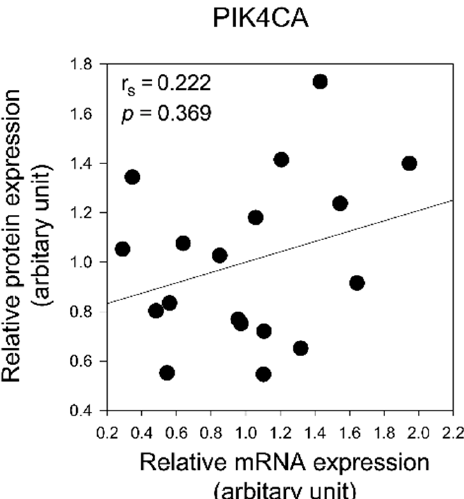
Figure 5. Correlation analysis of mRNA and protein expression of PIK4CA in the prefrontal cortex of patients with schizophrenia. Spearman’s correlation coefficient (r s ) and p value are indicated. The lines indicate the correlation trend.